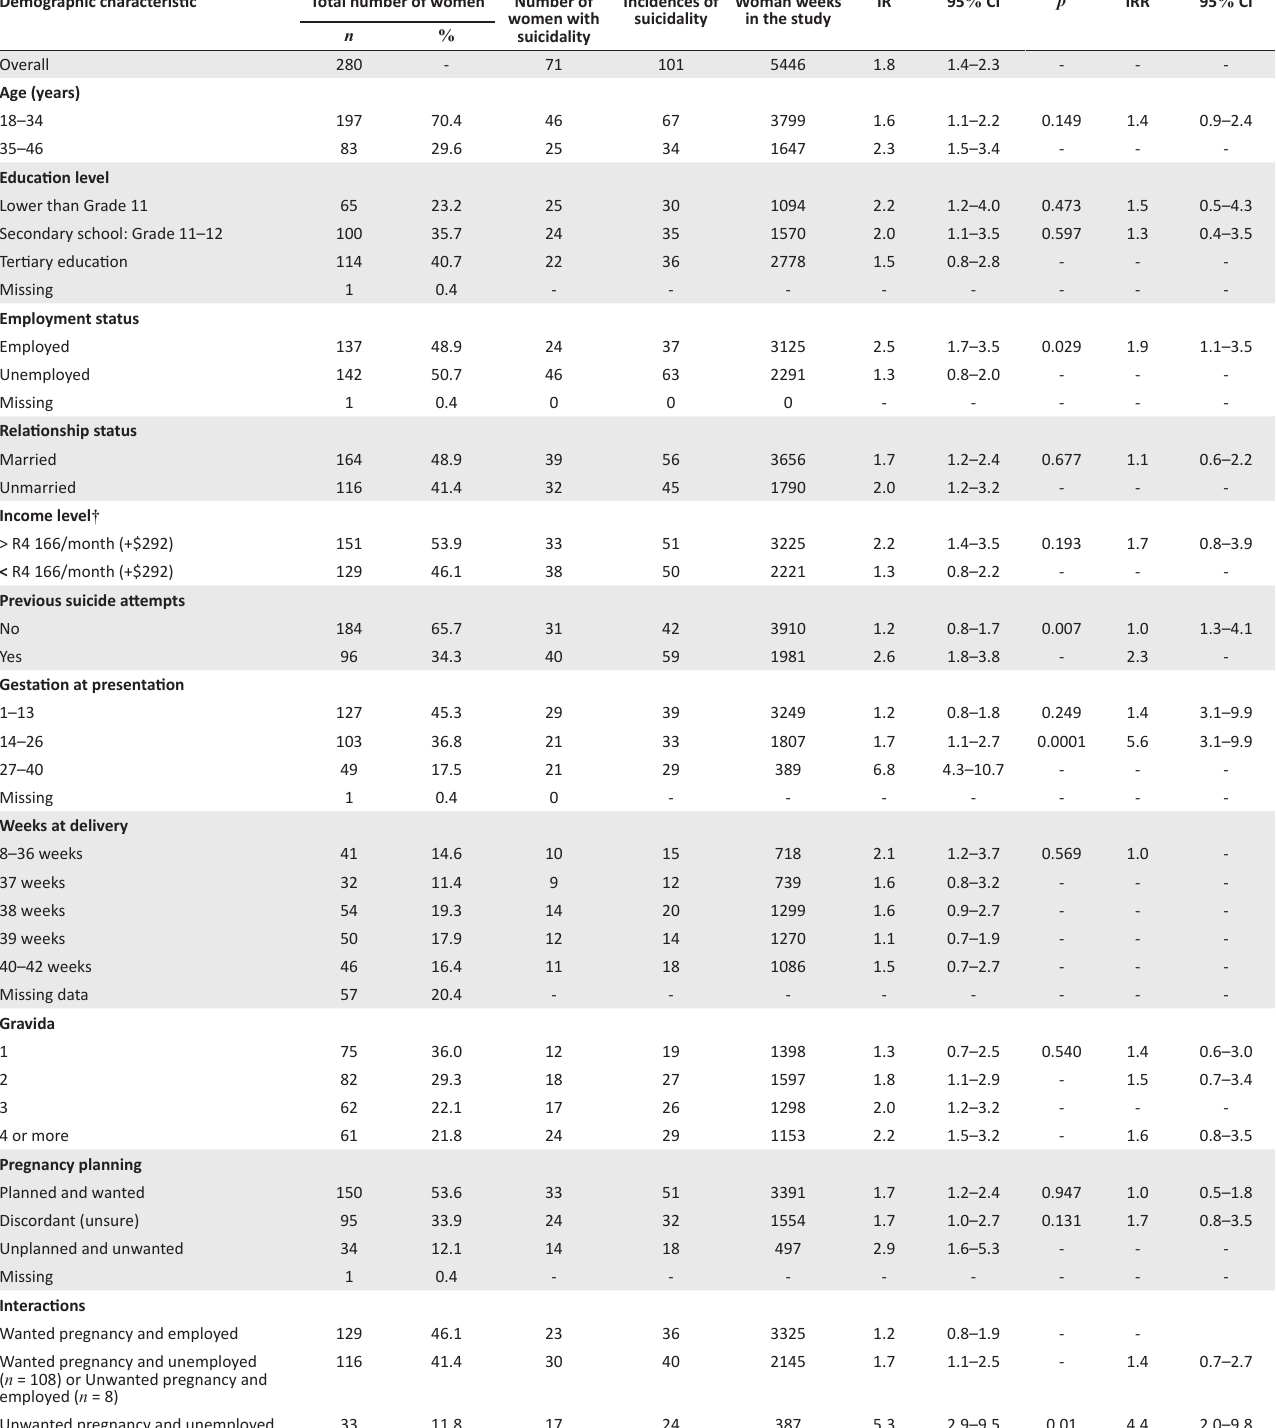
TABLE 1: The number of women, number of suicides and incidence of suicidality during pregnancy (incidence rate and 95 % confidence interval per 100 women weeks in the study) by maternal, demographic and pregnancy characteristics. Demographic